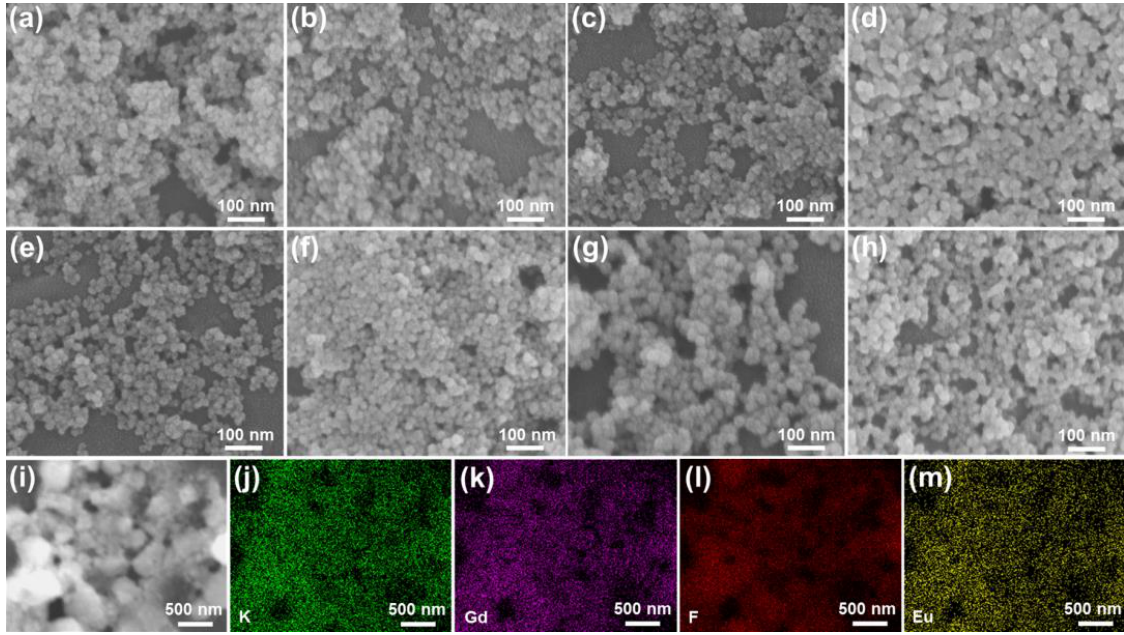
Figure 2. FE-SEM graphs of KGd 2 F 7 :2 x Eu 3+ nanoparticles with the doping contents of ( a ) x = 0.05, ( b ) x = 0.10, ( c ) x = 0.15, ( d ) x = 0.20, ( e ) x = 0.30, ( f ) x = 0.40, ( g ) x = 0.50 and ( h ) x = 0.60. ( i – m ) Elemental mapping of KGd 2 F 7 :0.60Eu 3+ nanoparticles.